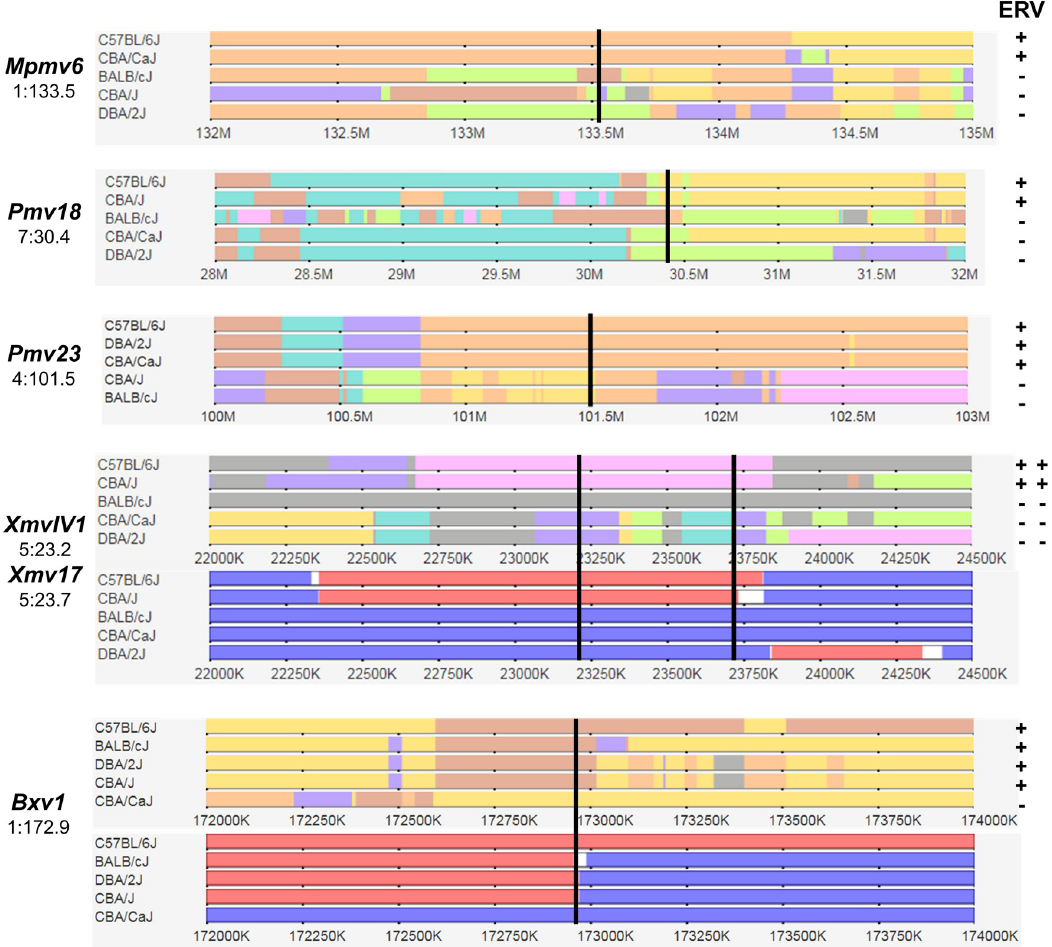
Fig 4. Wild mouse origins and haplotype identities for six ERVs. The horizontal tracks represent 2–4 megabase chromosome segments surrounding six specific ERV integration sites. ERVs and their genome locations are listed on the left and PCR typing data is on the right. The map locations for each ERV are marked by a vertical black line. Blocks of shared haplotypes are indicated in multiple colors; additional tracks for the three Xmvs show subspecies-specific blocks originating from M . m . domesticus in blue and from M . m . musculus in